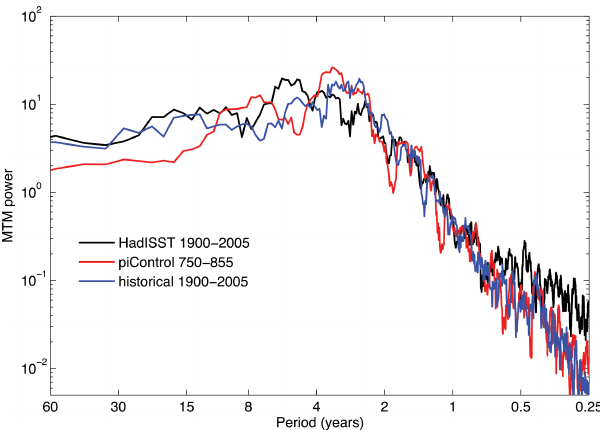
Fig. 17. Power spectra of the NINO3.4 index (the SST anomalies of Fig. 12 normalized with the standard deviation) using the multitaper method of Ghil et al. (2002) with resolution p =4 and number of tapers t =7. Data sources are HadISST (black), Historical1 (blue), and piControl (red).